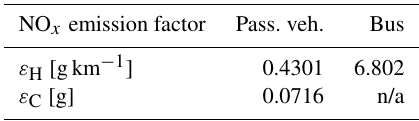
Table A3. Aggregated NO x emission factors for busses and passenger vehicles for HBEFA 3.3 for Germany.